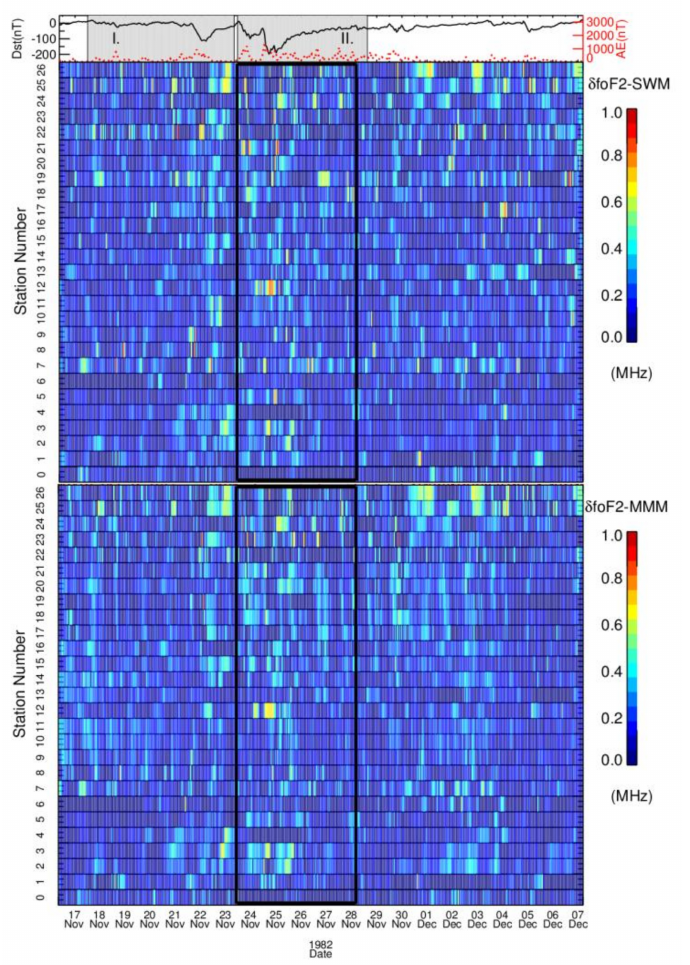
Figure 2. Temporal variation in Dst, AE (top panel), δ foF2-SWM (color blocks in middle panel), and δ foF2-MMM (bottom panel) from 17 November to 7 December